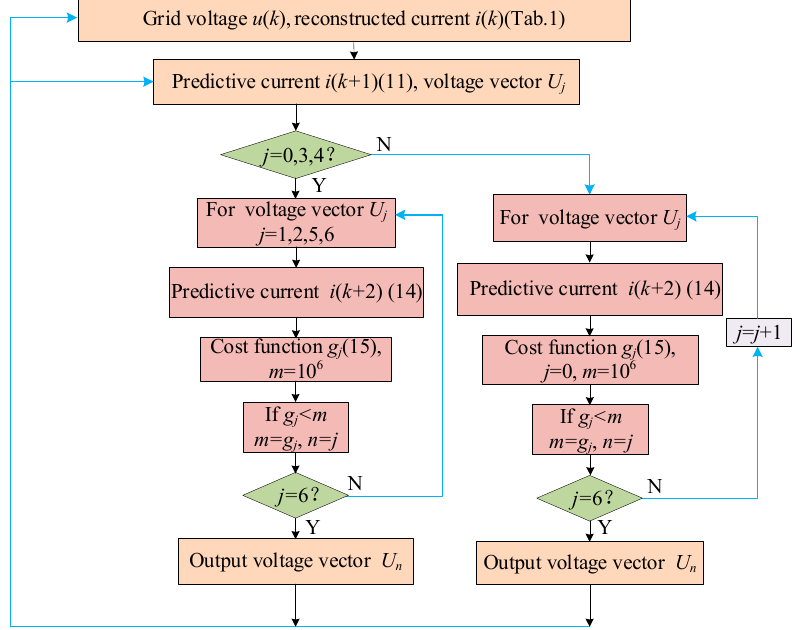
Figure 9. The flowchart of improved voltage selection with delay compensation.